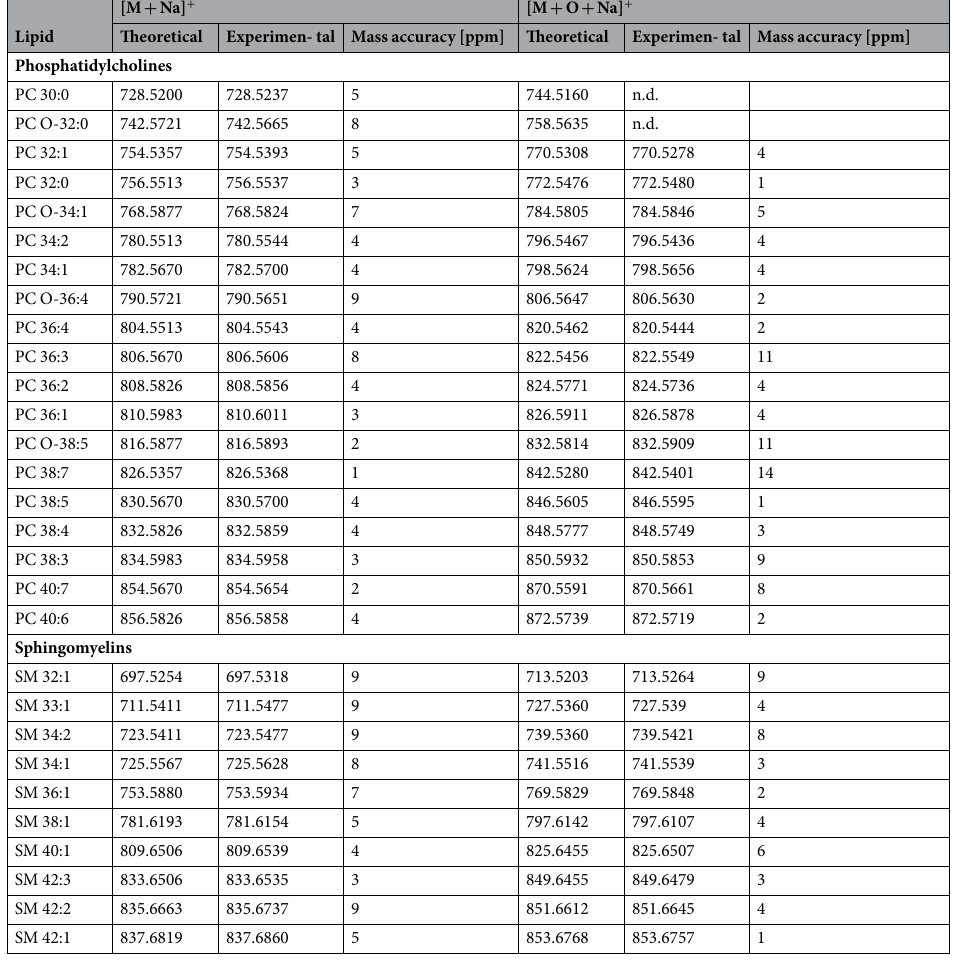
Table 1. Theoretical and experimental m/z values of lipid species identified in positive ion mode in tissue samples with measured mass